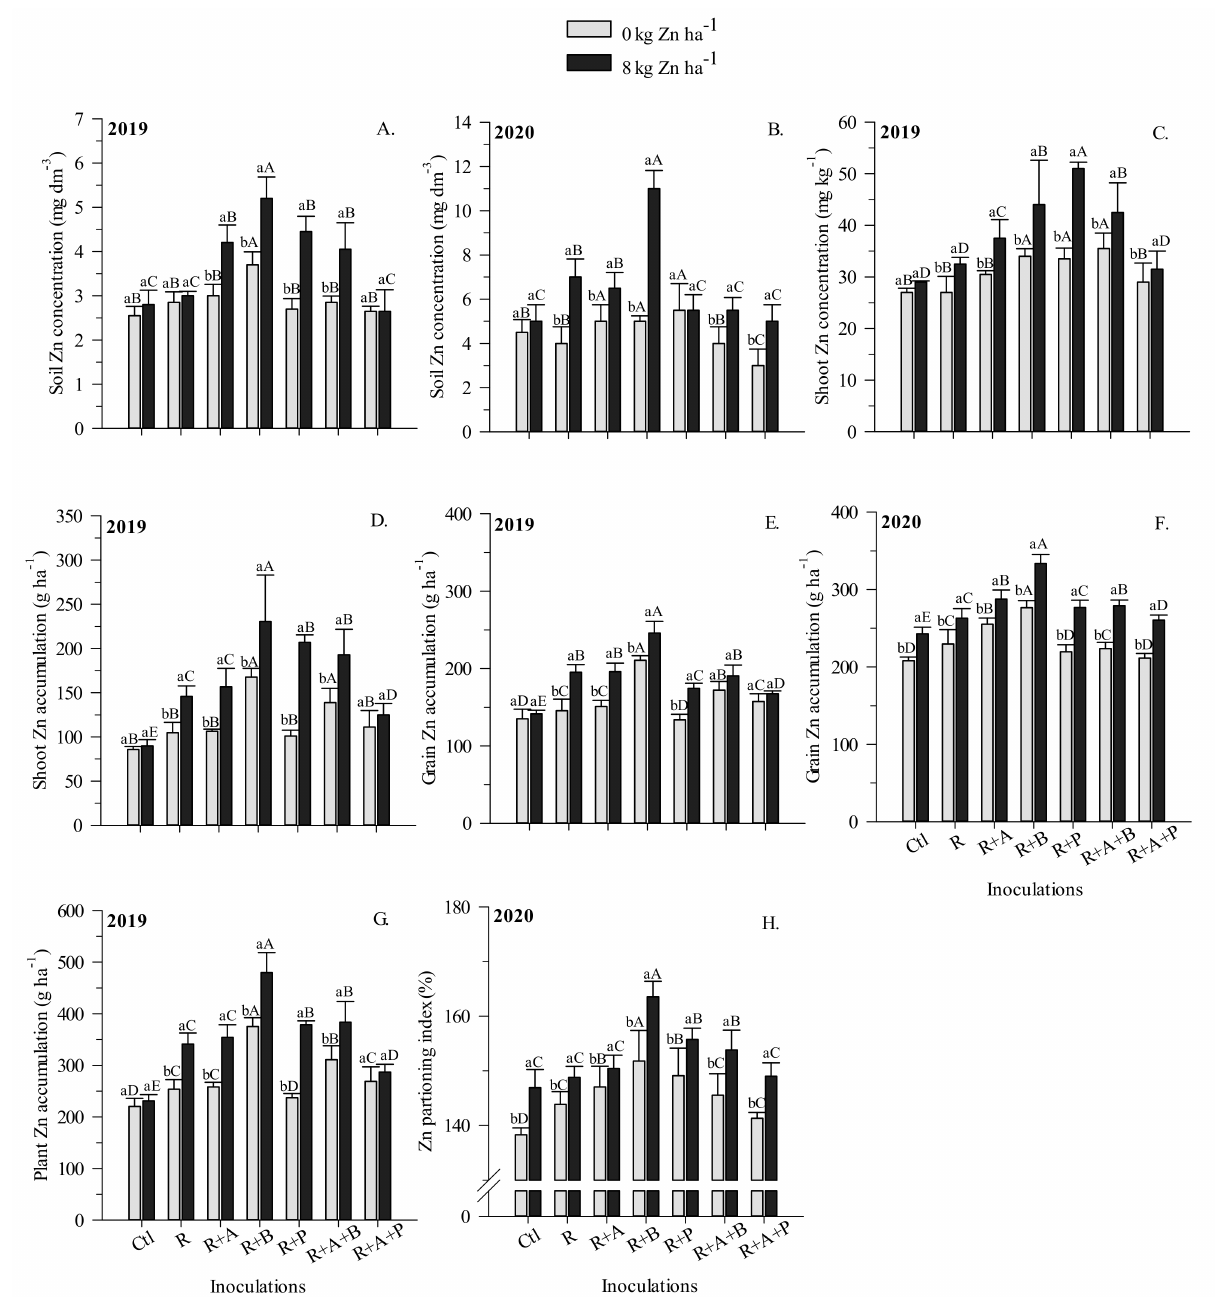
Figure 3. The influence of soil Zn and co-inoculations of different diazotrophic bacteria on soil Zn concentration, plant and grain Zn concentration and accumulation, and Zn partitioning index in common bean. ( A , B ) Soil Zn concentration (mg dm − 3 ) in 2019 and 2020, respectively; ( C ) Shoot Zn concentration (mg) in 2019; ( D ) Shoot Zn accumulation (g kg − 1 ) in 2019; ( E , F ) Grain Zn accumulation (g kg − 1 ) in 2019 and 2020, respectively; ( G ) Plant Zn (straw + grain) accumulation in 2019; and ( H ) Zn partitioning index (%) in 2020. Ctl (No inoculation); R ( R. tropici ); R + A ( R. tropici + A. brasilense ); R + B ( R. tropici + B. subtilis ); R + P ( R. tropici + P. fluorescens ); R + A + B ( R. tropici + A. brasilense + B. subtilis ); and R + A + P ( R. tropici + A. brasilense + P. fluorescens ). The uppercase letters are used for inoculation interactions within each level of soil Zn application, whereas lowercase letters are used for the unfolding of Zn levels within each inoculation treatment. The identical alphabetic letters do not differ from each other, as analyzed by Tukey (Zn application; p < 0.05) and Scott–Knott (inoculations; p < 0.05) tests for 2019 and 2020, respectively. Error bars indicate the standard error of the mean (n = 4 replications). Selv í ria,